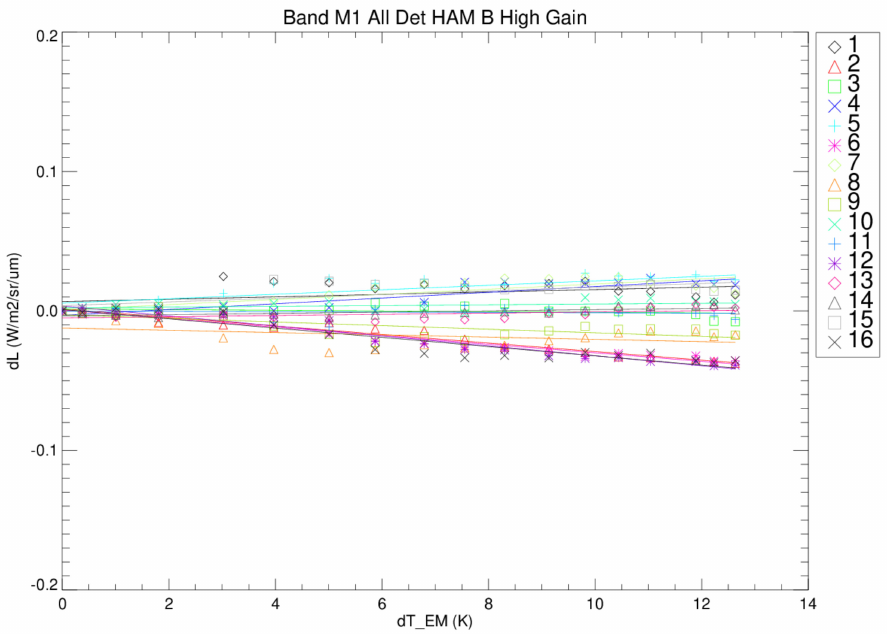
Figure 14. Band M1 temperature sensitivity (dL) as a function of electronics module (EM) temperature change between nominal and hot plateau for each detector (colors and symbols).